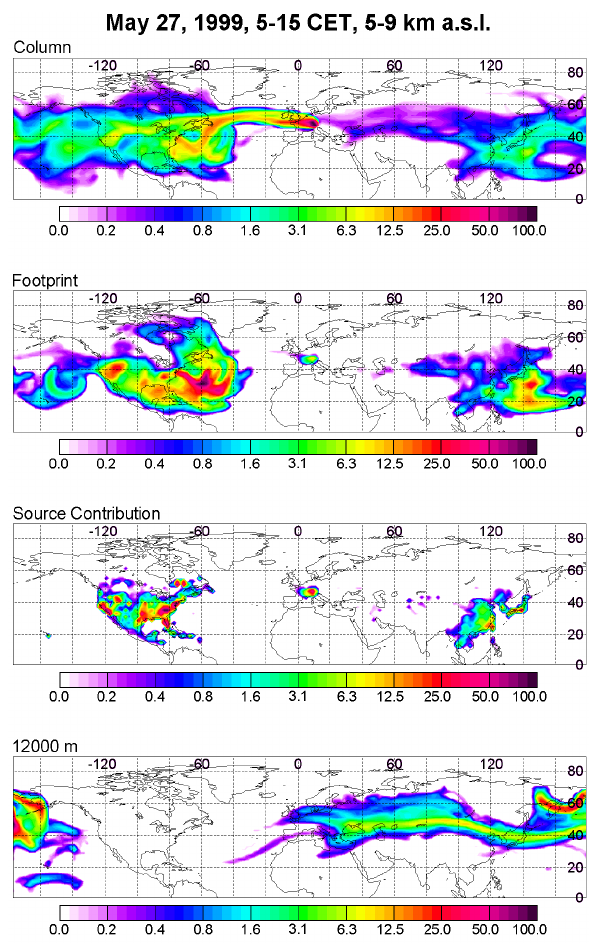
Fig. 9. Fifteen-day backward simulation with FLEXPART for 27 May 1999, between 05:00 and 15:00CET, corresponding to the measurements in Fig. 8b and c (see Fig. 2 for more